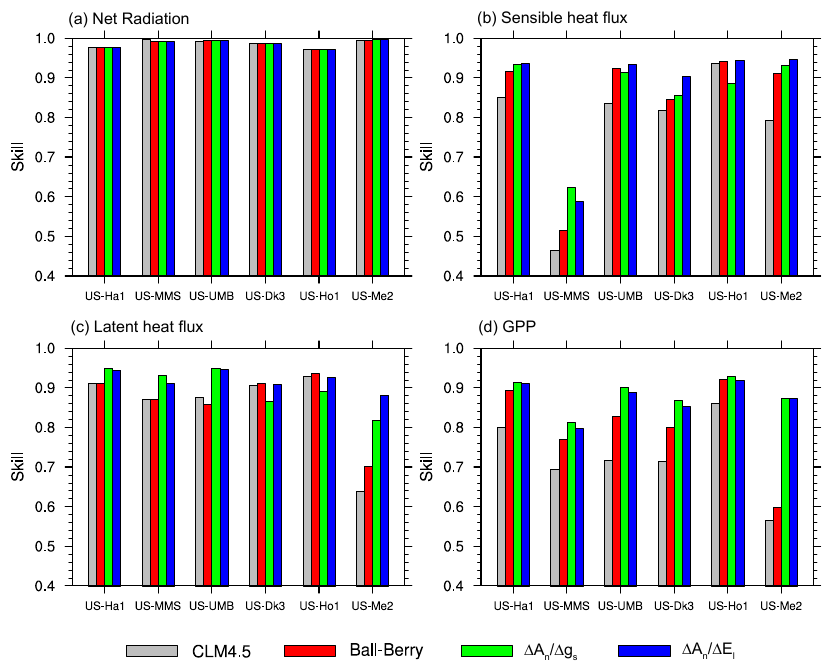
Figure 9. Average skill across all years for each flux tower site for (a) net radiation, (b) sensible heat flux, (c) latent heat flux, and (d) gross primary production. Shown are simulations for CLM4.5 and the multi-layer canopy model with the CLM Ball–Berry model, SPA-iWUE optimization, and SPA-WUE optimization. Stomatal efficiency is ι ∗ = 15µmolCO 2 mol − 1 H 2 O (iWUE optimization) and ι = 1500µmolCO 2 mol − 1 H 2 O (WUE optimization) for US-Ho1 and US-Me2. All other parameter values are as in Table